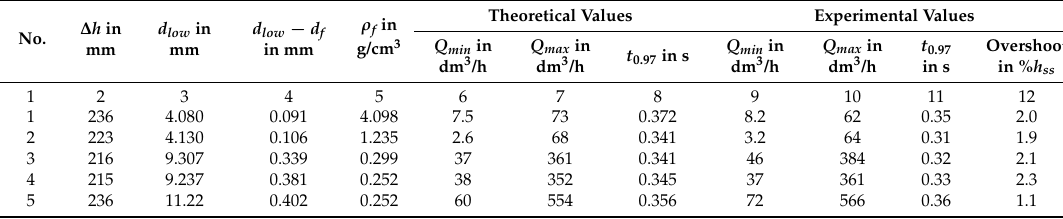
Table 4. Results of float optimization for tubes specified in the Table